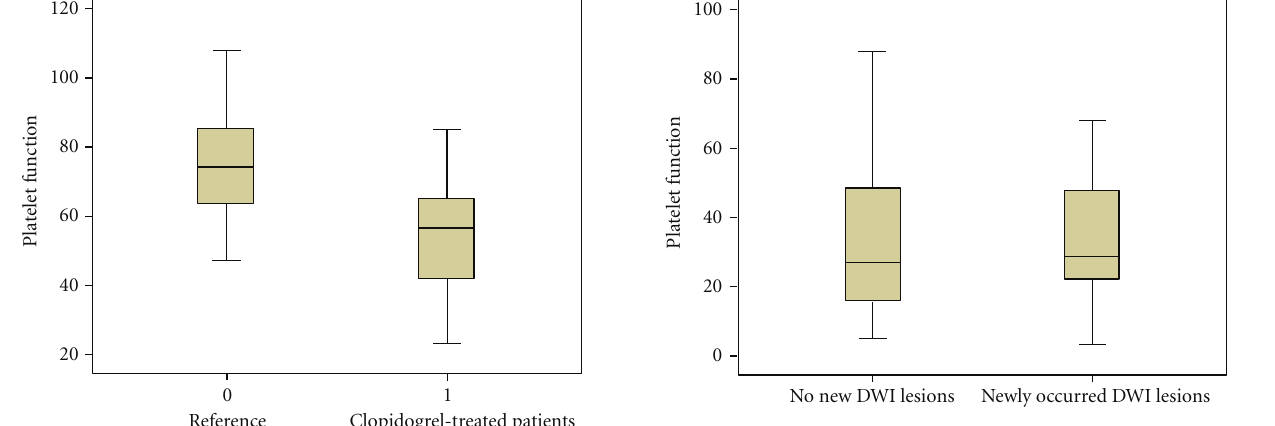
Figure 1: Distribution of ADP values from the study population, including three patients that received a loading dose, and those from the reference group (“Reference” in this figure means a combined reference range of healthy male and female blood donors).